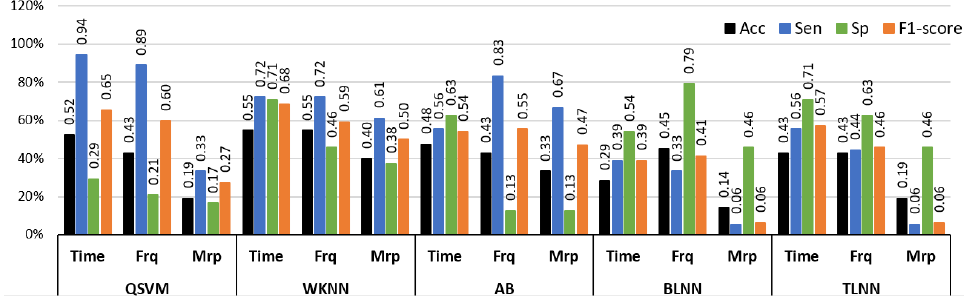
Figure 10. Performance evaluation with time, frequency (Frq), and morphological (Mrp) features using different classifiers for Experiment 3 (no pain vs. low pain vs. high pain). (QSVM: Quadratic- SVM, WKNN: Weighted-KNN, AB: AdaBoost, BLNN: bi-layered neural network, TLNN: tri-layered neural network). Table 7. Performance evaluation with combinations of time, frequency (Frq), and morphological (Mrp) features using different classifiers for Experiment 3 (No Pain vs. Low Pain vs. High Pain). (QSVM: Quadratic-SVM, WKNN: Weighted-KNN, AB: AdaBoost, BLNN: bi-layered neural network, TLNN: tri-layered neural network. Bold text indicates the best results.